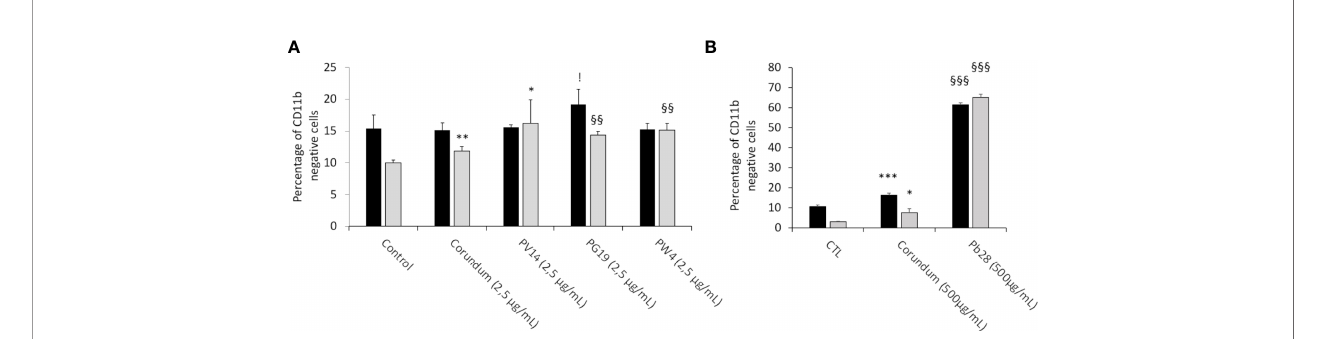
FIGURE 14 | CD11b cell surface marking. Black bars: acute exposure (24 hours). Grey bars: exposure for 24 hours followed by a3-day post-exposure recovery period. Panel (A) percentage of CD11b- cells in comparison to unlabeled control cells. Conditions with 2.5 µg/ml of particle suspension. Panel (B) percentage of CD11b- cells in comparison to unlabeled control cells. Conditions with 500 µg/ml of particle suspension. Signi fi cance of symbols: *: different from negative control only; §: different from both negative and corundum controls;!: different from corundum control only. Number of symbols: 1: p < 0.05; 2: p < 0.01; 3: p